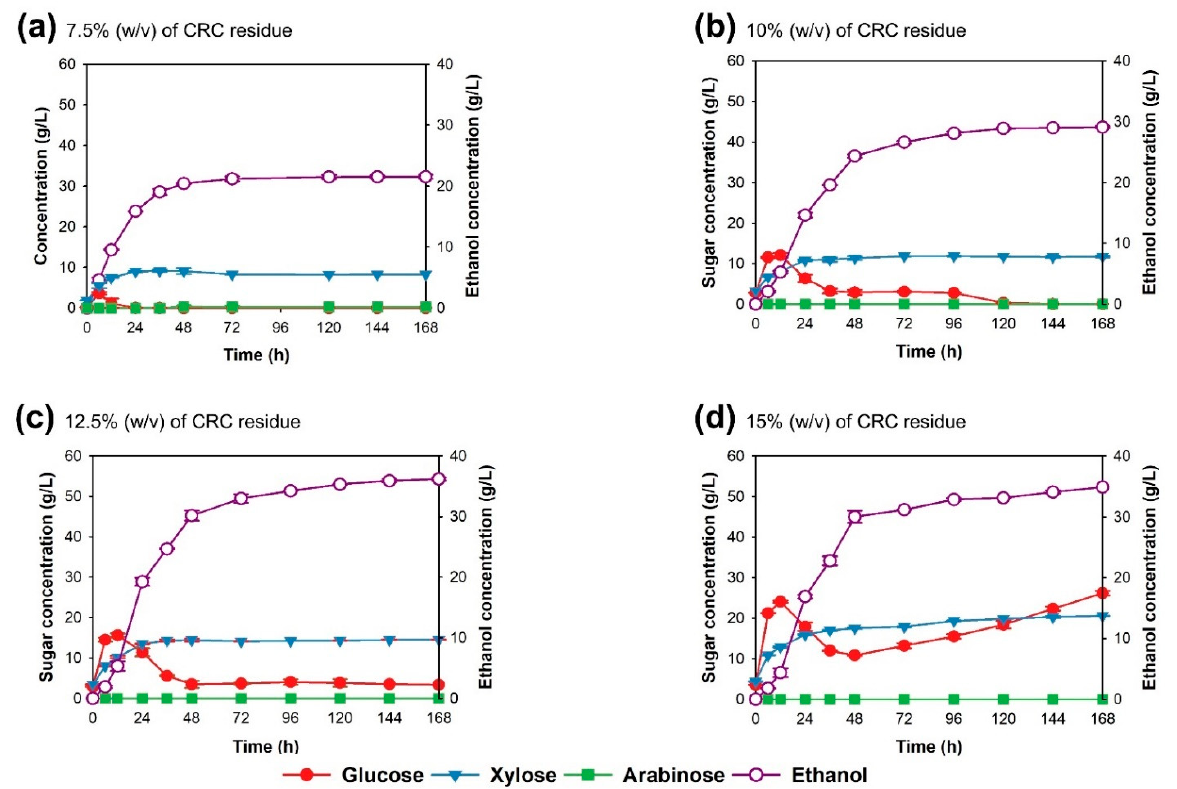
Figure 3. Effect of solid loading at 7.5 ( a ), 10 ( b ), 12.5 ( c ), and 15% ( d ) ( w / v ) cellulose-rich corncob residue on ethanol fermentation by the thermotolerant S. cerevisiae TC-5 via simultaneous saccharification and fermentation conducted in a 100-mL laboratory bottle at 40 °C for 168 h. Table 1. Ethanol production from CRC via batch and fed-batch simultaneous saccharification and fermentation (SSF) at different cellulose-rich corncob (CRC) solid loadings by the thermotolerant S. cerevisiae TC-5 at 40 °C. Processes CRC Loading (%, w / v